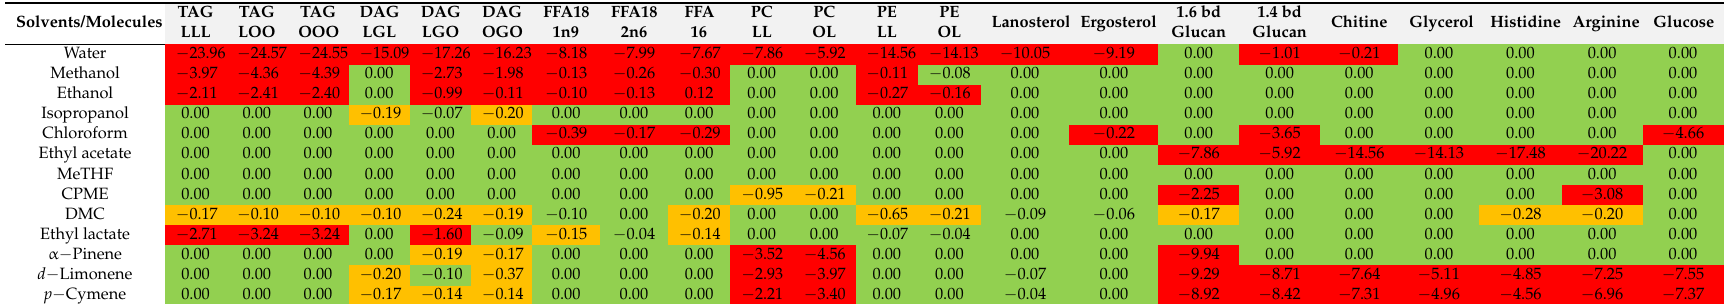
Table 1. Conductor-like Screening MOdel for realistic Solvatation (COSMO-RS) results; simulation of modeled molecules in several alternative solvents for the substitution of chloroform and methanol. Green (0), yellow ( − 0.1 ≤ x ≤ − 0.99), red ( − 1 ≤ x ≤ − 5). Solvents/Molecules TAG